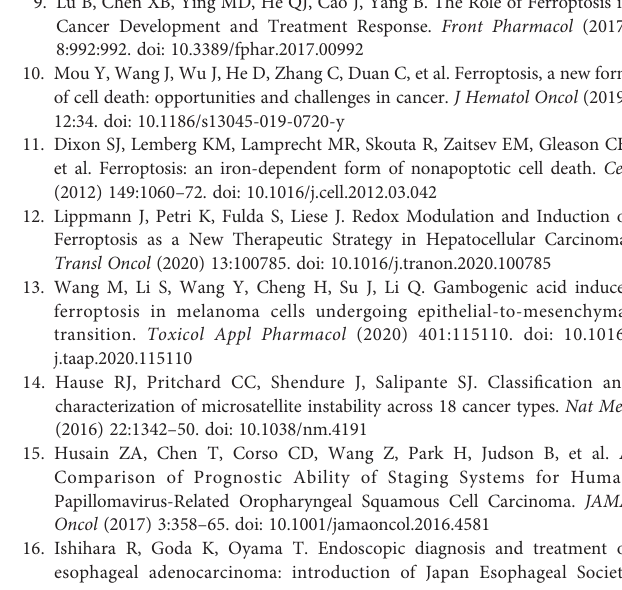
SUPPLEMENTARY FIGURE 1 | LASSO analysis of IMRGs related to OS and DFS. (A, C) Draw a dashed vertical line with the best value by using the minimum standard. (B, D) LASSO coef fi cient curves of IMRGs related to candidate OS (B) and DFS (D) . LASSO, the smallest absolute contraction and selection operator; IMRGs, iron metabolism-related genes; OS, overall survival; DFS, disease-free